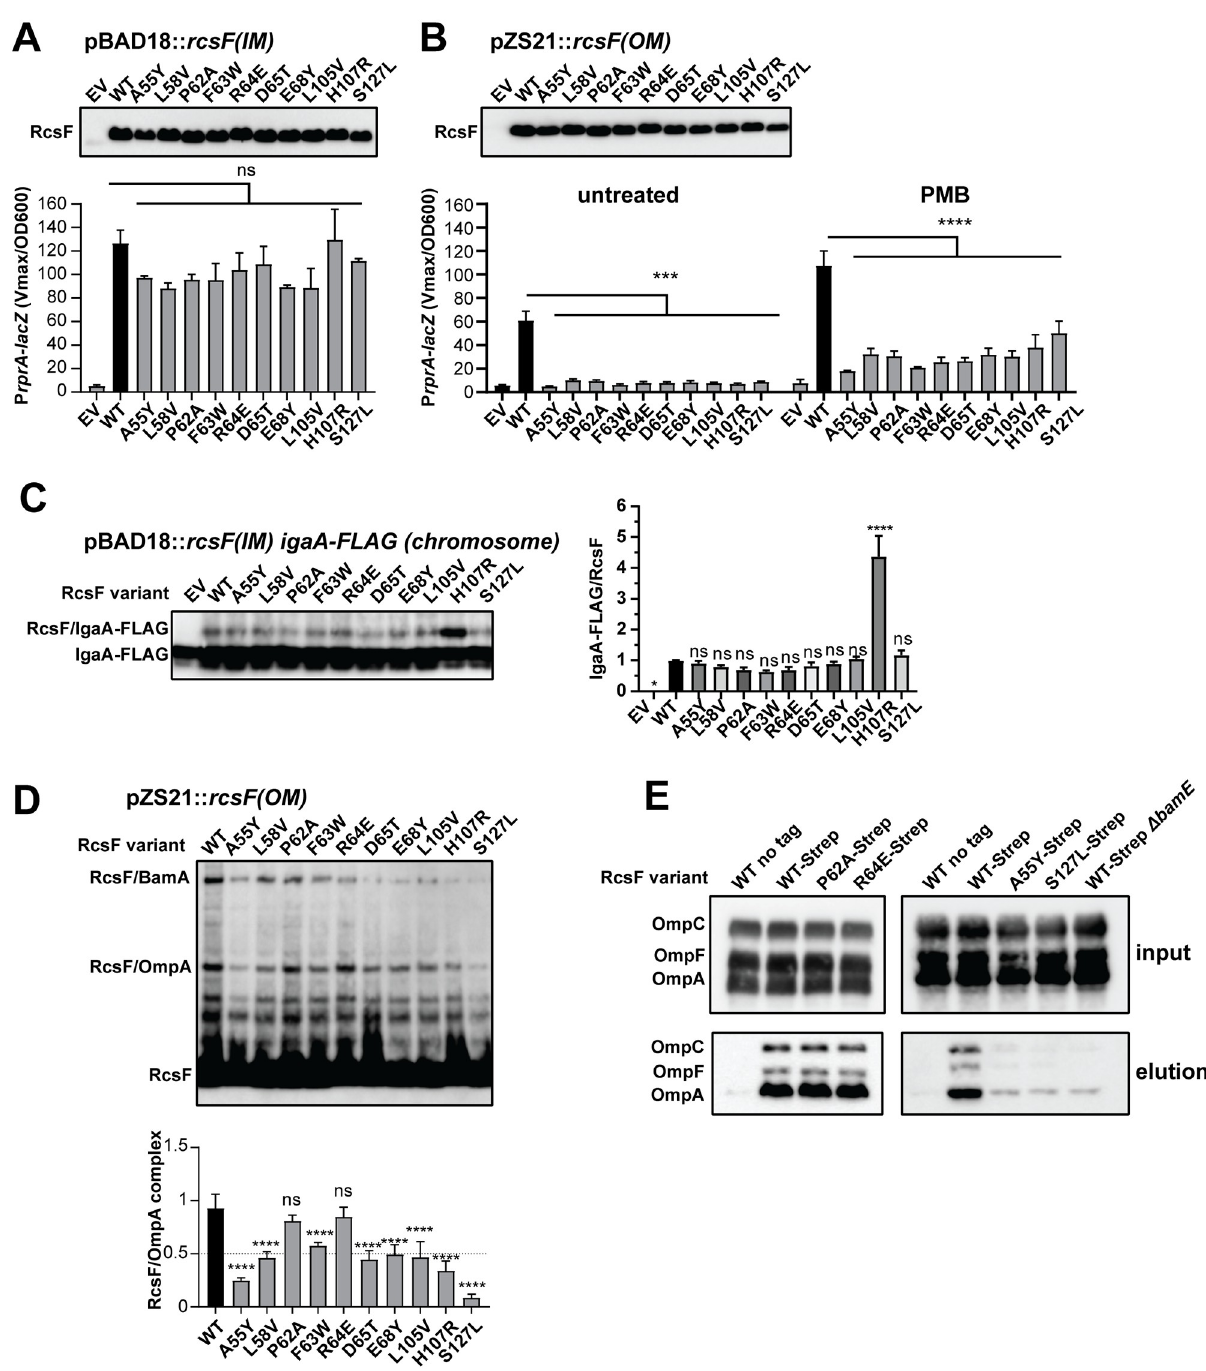
Fig 5. Characterization of RcsF LOF[OM] variants. LOF[OM] mutations were introduced on a plasmid encoding IM (A) or OM (B) rcsF and analyzed by immunoblotting with α -RcsF antibodies and by a β -galactosidase assay using a P rprA-lacZ transcriptional reporter. Where indicated, strains were treated with 0.75 μ g/ml PMB for 40 min. Graphs represent mean β -galactosidase activity normalized to OD600, +/- SD. (C) LOF[OM] mutations were introduced into IM localized RcsF and tested for crosslinking to the chromosomally encoded IgaA-FLAG. Immunoblot analysis of in vivo formaldehyde crosslinked samples probed with α -FLAG. RcsF/IgaA band was quantified relative to the WT. Graph represents mean of independent experiments +/- SD. (D) LOF[OM] variants display varying levels of RcsF/OmpA crosslinking. Immunoblot analysis of in vivo formaldehyde crosslinked samples probed with α -RcsF antibodies (top). Immunoblot quantification of RcsF/OmpA relative to the WT (bottom). Graphs represent mean of three independent experiments +/- SD. (E) In vivo pull-down in the absence of crosslinking. Solubilized membrane fractions of strains expressing indicated RcsF variants were subjected to Streptactin sepharose purification. Immunoblots of input and elution fractions were